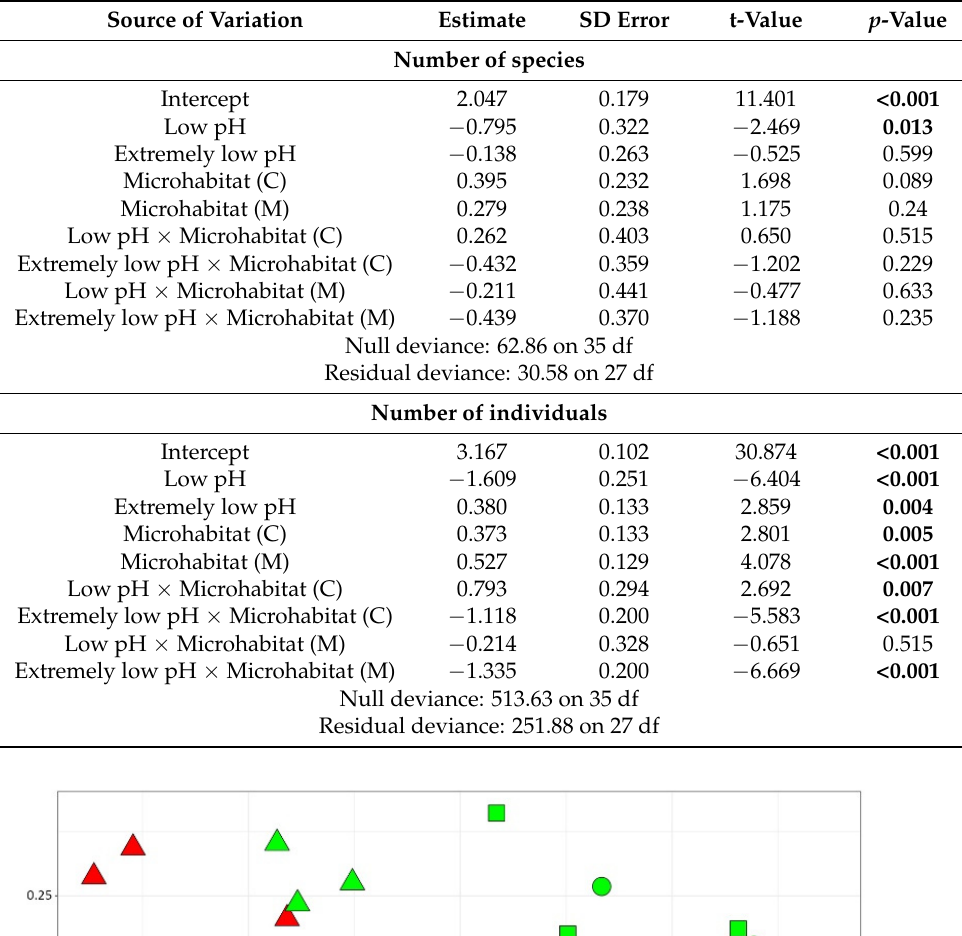
Table 5. Output of the GLMs fitted to the number of taxa and number of individuals in the three microhabitats at the Vu site. Significant values are highlighted in bold.